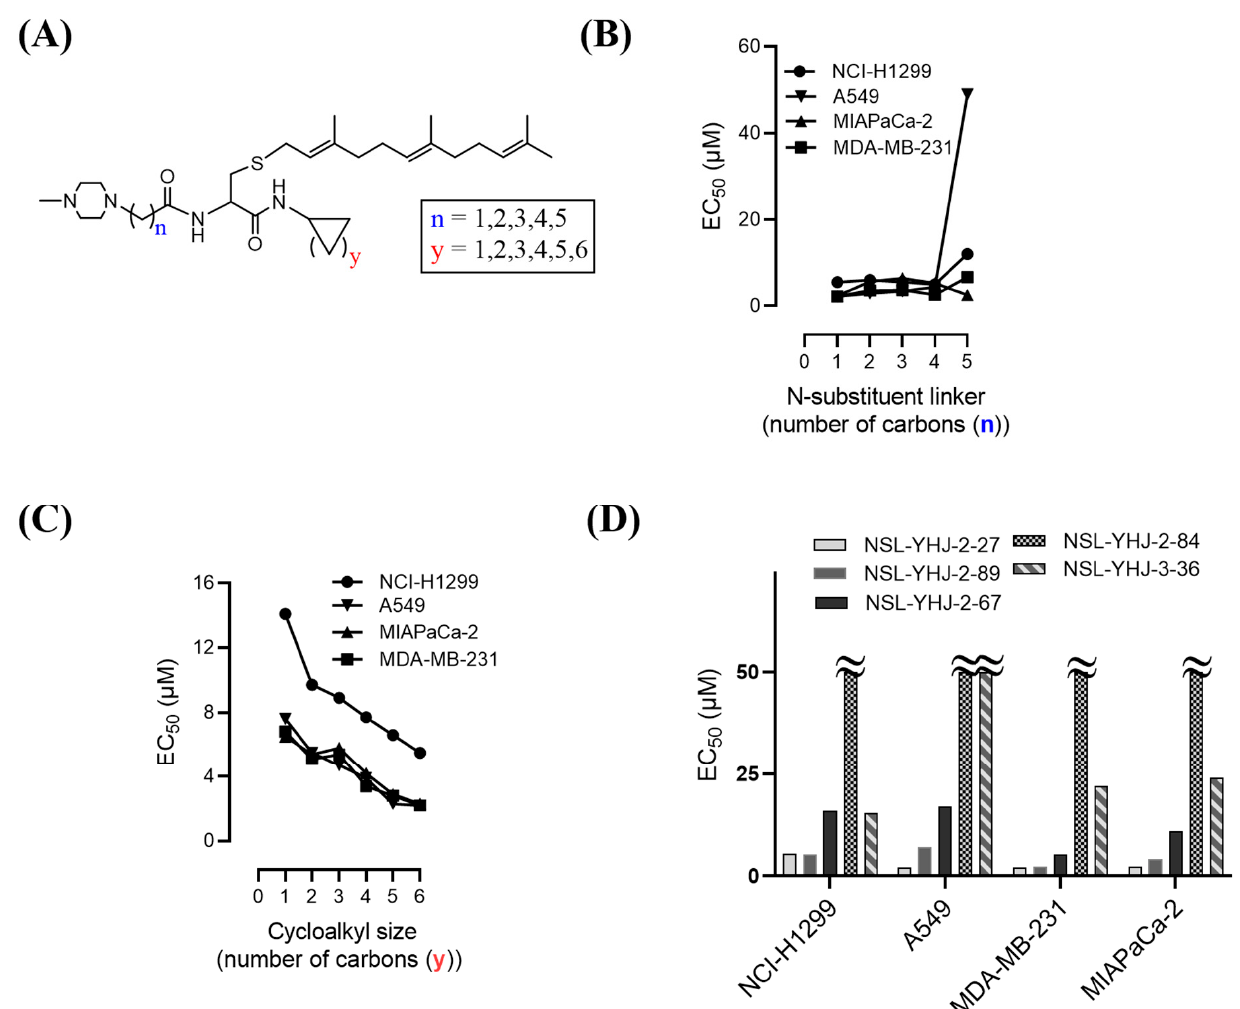
Figure 2. Structure–activity relationships. ( A ) PCAIs general structure showing areas of structural variation depicted by “n” and “y”; ( B ) effect on potency of PCAIs’ tether (linker/N-substituent chain) lengths; ( C ) effect on potency of the N-cycloalkyl ring size; and ( D ) comparative effectiveness of S-farnesylated (NSL-YHJ-2-27) versus S-geranylgeranylated (NSL-YHJ-2-89), pyrollidine-capped (NSL-YHJ-2-67) versus methylpiperidine-capped (NSL-YHJ-2-27), and ester-capped (NSL-YHJ-2-84) versus carboxylic acid-capped (NSL-YHJ-3-36) tethers.